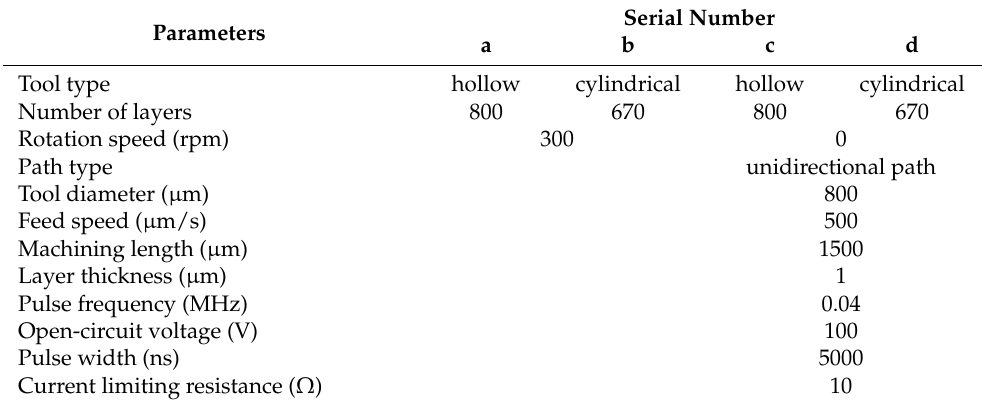
Table 4. Machining parameters for Exp.